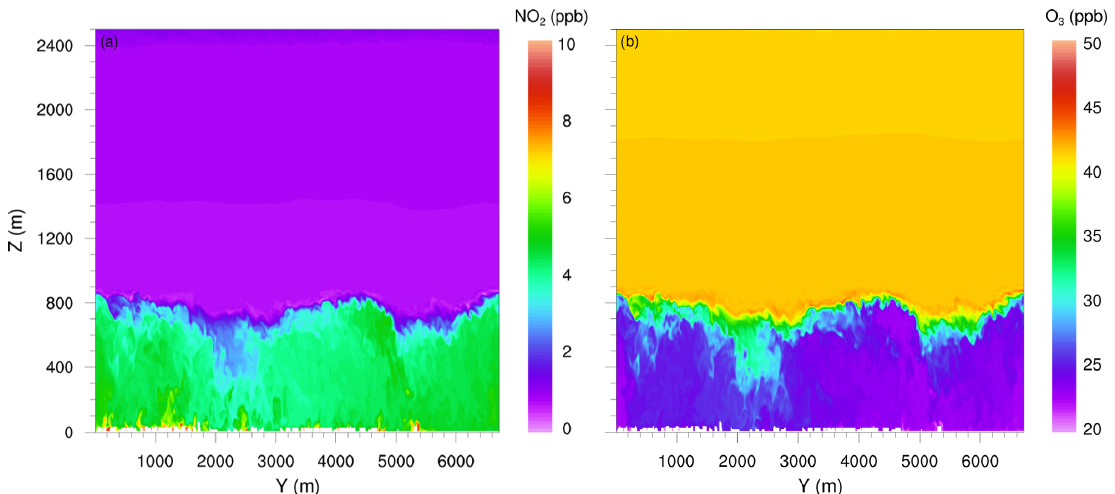
Figure 5. YZ vertical cross sections of NO 2 and O 3 (drawn through Hardenbergplatz, Fig. 2a), simulated with the CBM4 mechanism at 09:00CEST on 17 July